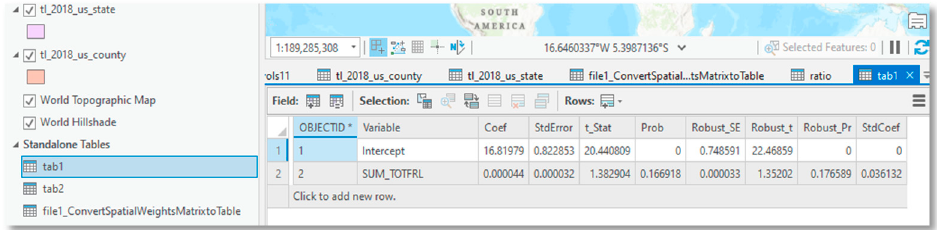
Figure 8. The spatial weighted matrix.